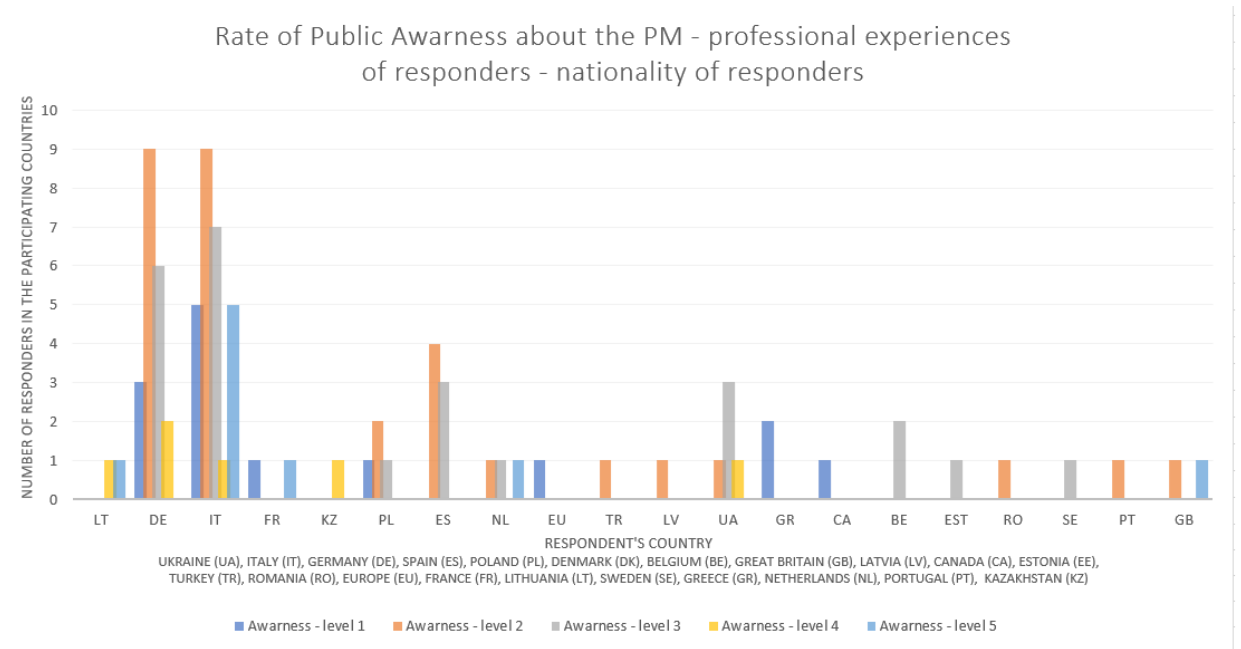
Figure 2. Rate of public awareness of PM—professional experiences of the respondents—break ‐ down by respondents’ nationality (survey data)—dot plot.